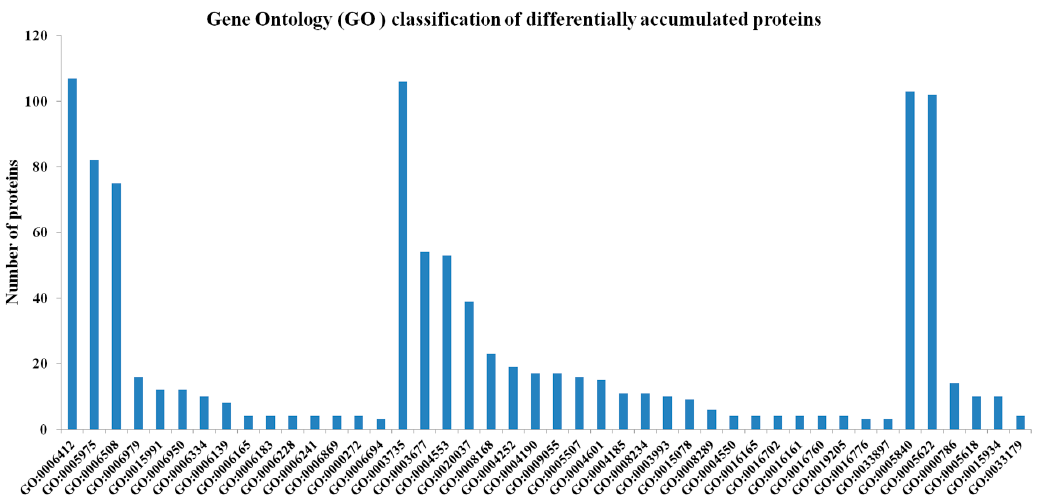
Figure 1. Gene Ontology (GO) classification of differentially accumulated proteins during pitaya fruit ripening. GO:0006412//translation, GO:0005975//carbohydrate metabolic process, GO:0006508//